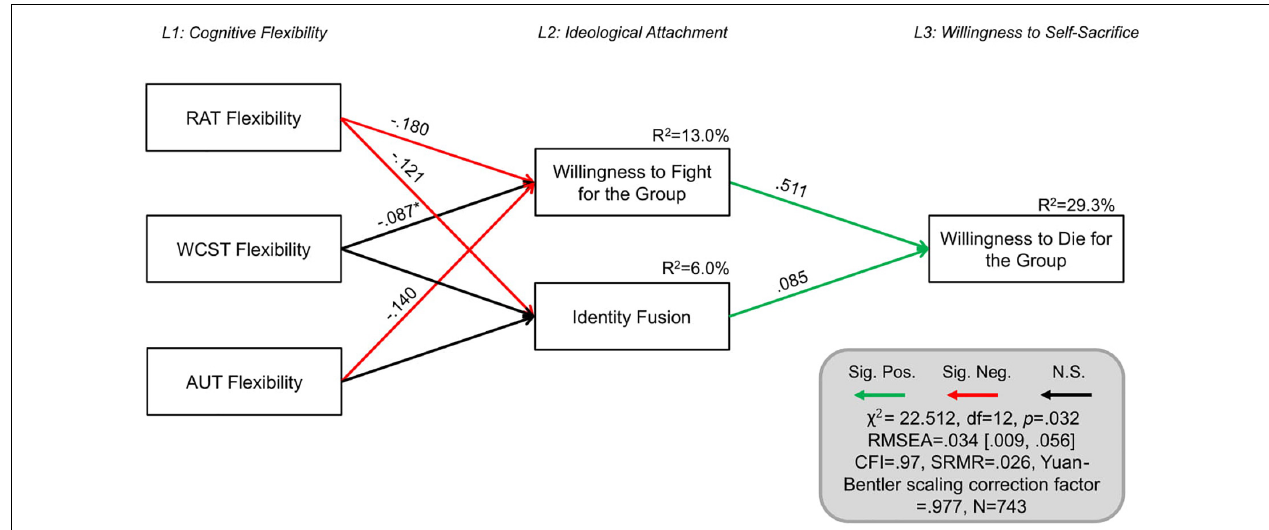
FIGURE 3 | Structural equation model predicting willingness to sacrifice oneself for the group. All parameters shown are fully standardized. For unstandardized estimates, SEs, and confidence intervals, see Supplementary Data . Significant parameter estimates are shown in red and green bolded lines. Residual covariances between variables on the same level are allowed, but not shown for simplicity. Model controls for demographic variables (age, gender, and educational attainment). Significance level was p < 0.05. ∗ p = 0.087. L1, level 1; L2, level 2; and L3, level 3. Figure design was inspired by Kievit et al. (2016).